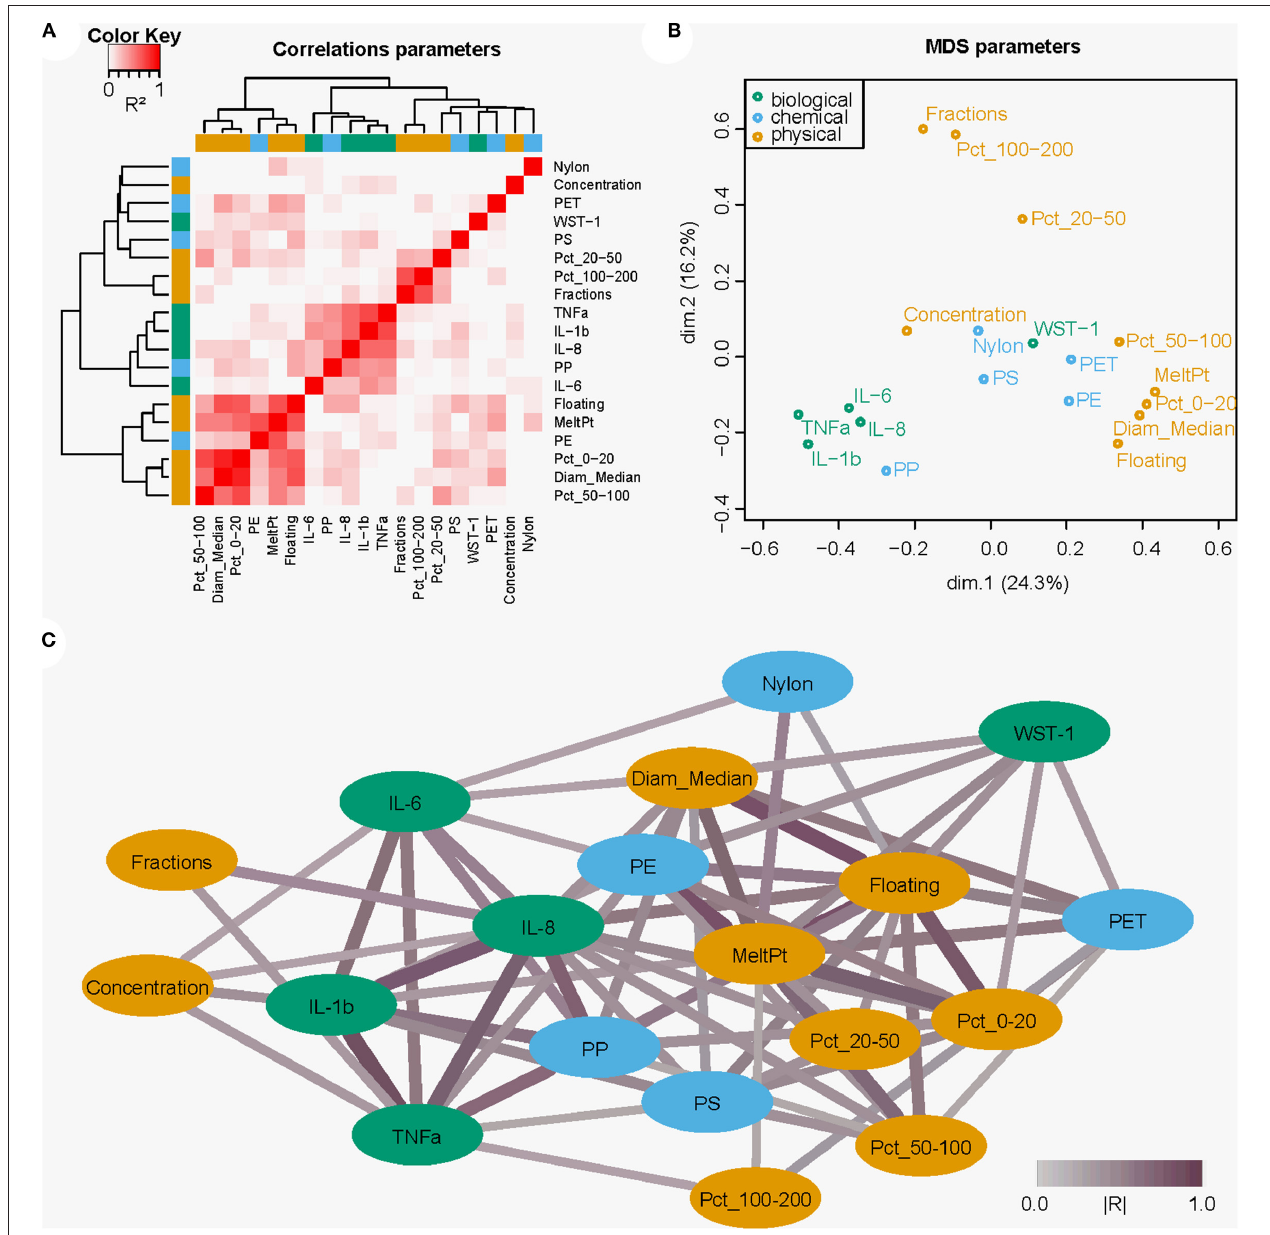
FIGURE 6 | Multivariate and network analysis approach visualizing the relationships between the chemical and physical particle properties and biological responses of THP-1 cells to the microplastic samples. (A) Heatmap showing correlations (R2) between selected parameters and clustering of the parameters on similarity. (B) Multidimensional scaling showing (dis)similarities (based on the calculated correlations) as distances between the parameters. (C) Cytoscape network analysis showing significant parameter correlations as network connections. Line color indicates correlation strength, with deeper shades of purple indicating higher |R| values. In orange the physical parameters, blue chemical, and green